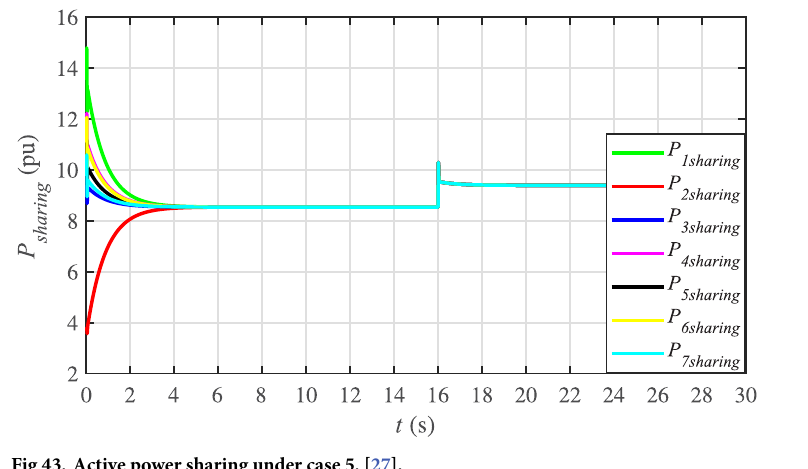
Fig 43. Active power sharing under case 5. [27].